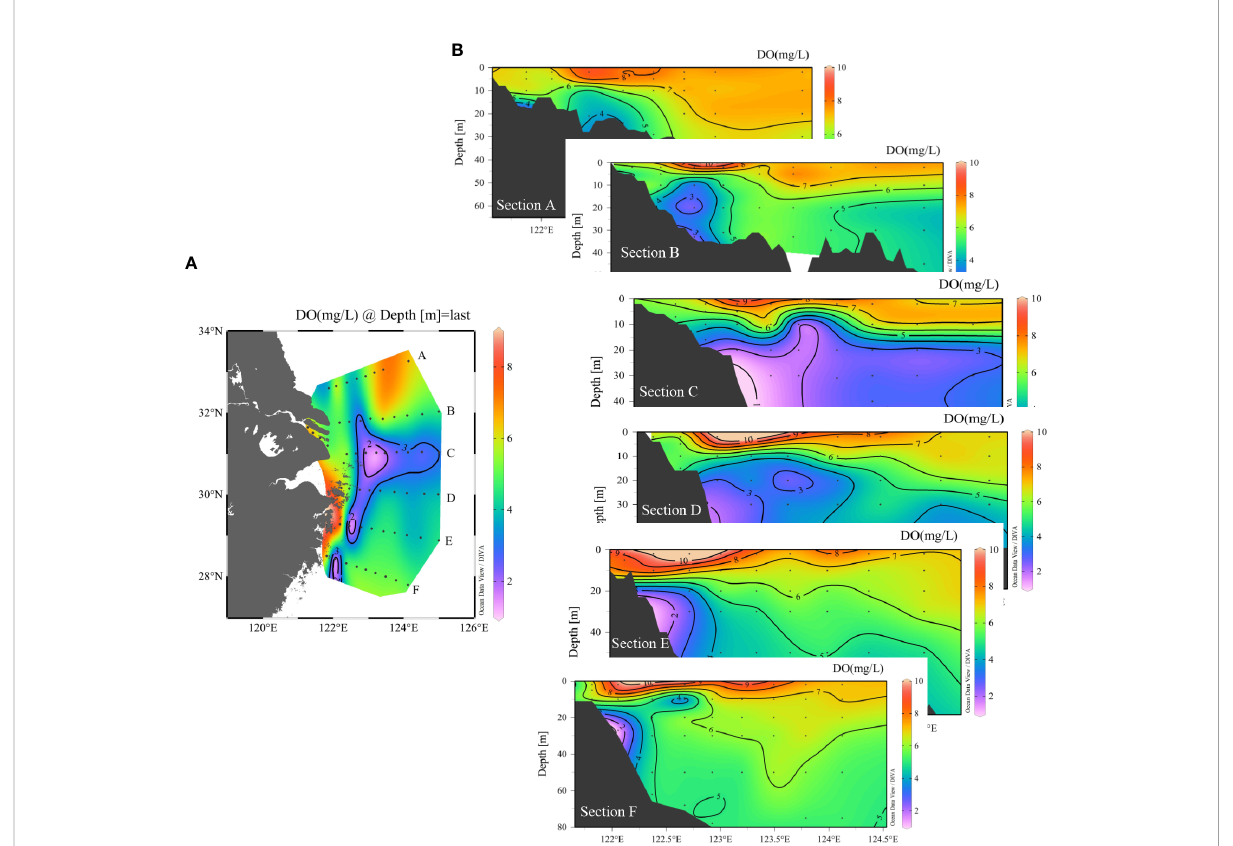
FIGURE 3 Transect DO distribution from north to south. Bottom purple areas represented the hypoxic area in each section (A – F). (A) Hypoxic zone in the bottom. (B) Transect distribution of DO from north to south. The location of each transect was located on the left station map marked with a